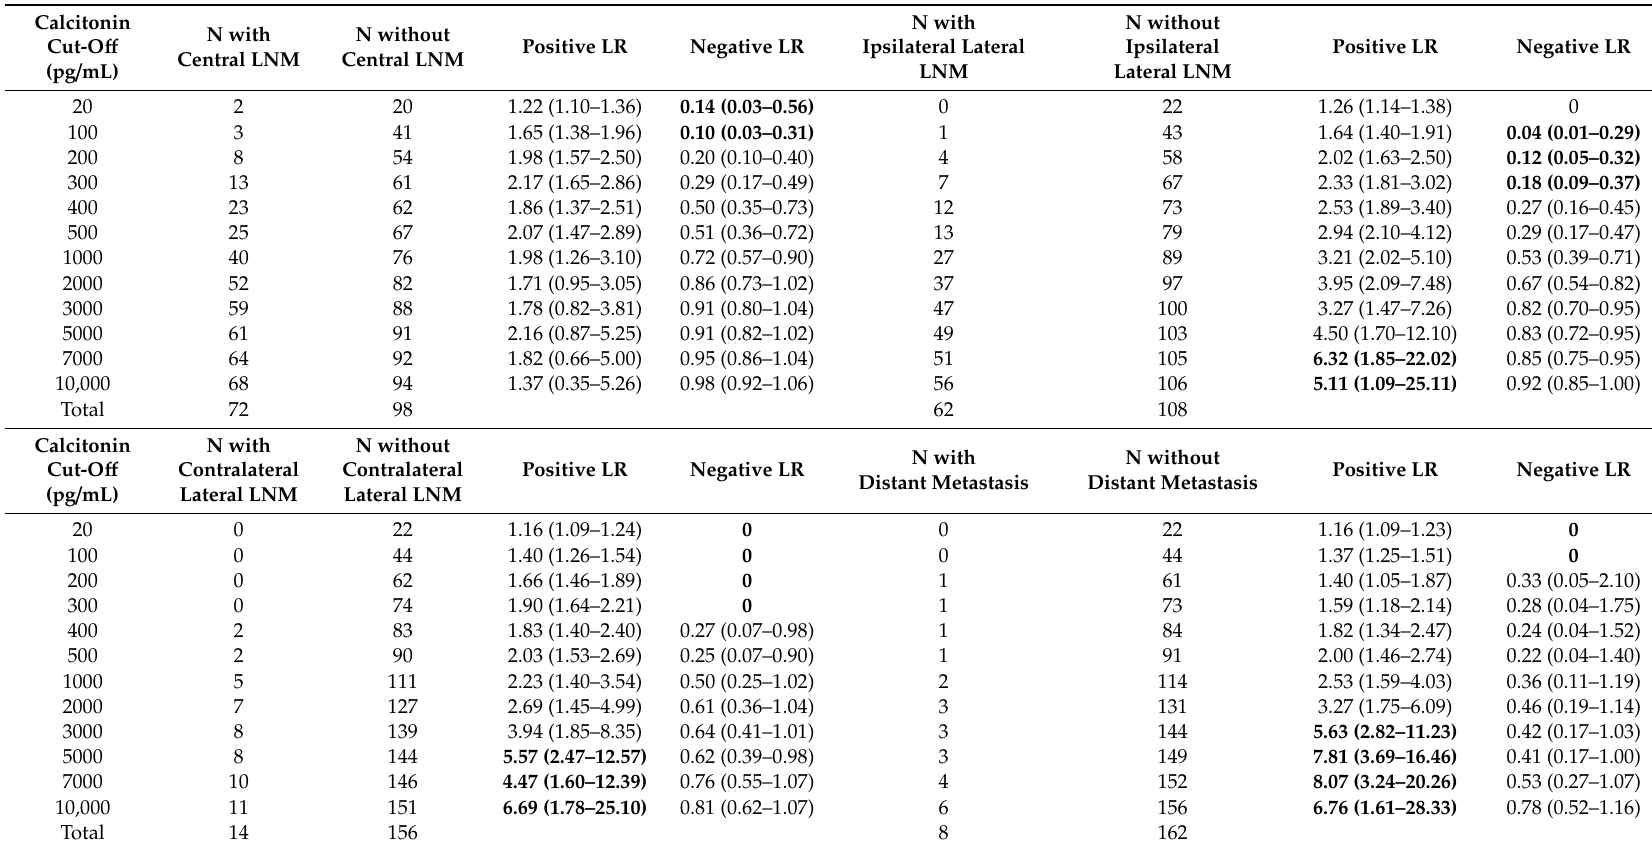
Table 6. Likelihood ratios for preoperative serum calcitonin levels in diagnosing lymph node metastasis and distant